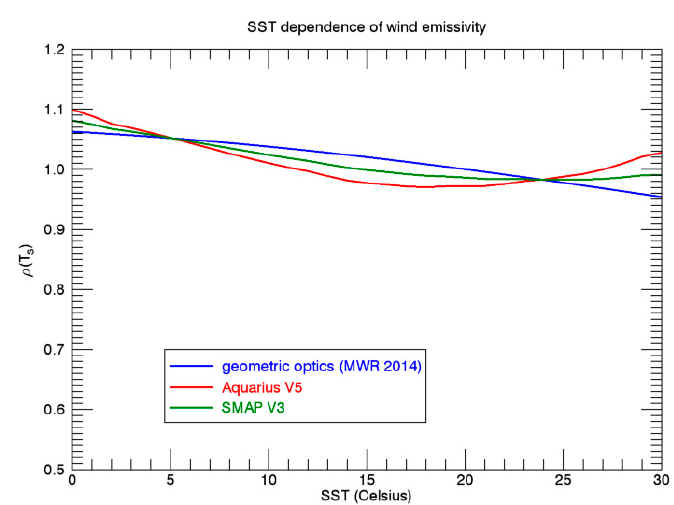
Figure 2. SST dependence of the wind induced emissivity for Aquarius horn 2 H-pol. The blue line in the SST dependence from [12], which is predicted by the geometric optics model for the wind induced surface emission and which was used in earlier Aquarius releases. The red line is the SST dependence used in the Aquarius Version 5 release. The green line is the SST dependence used in the SMAP Version 3 release (Section 10).